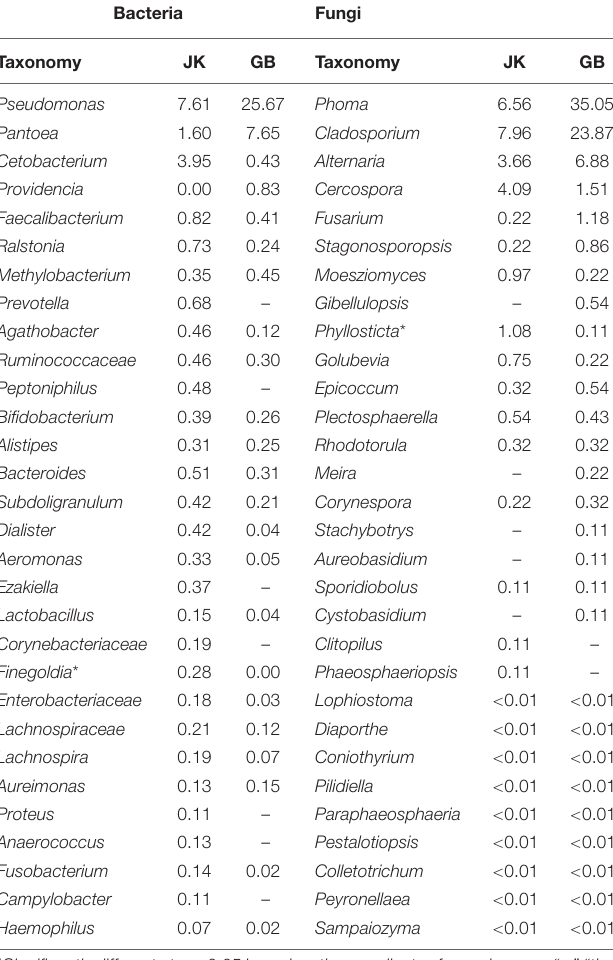
TABLE 2 | The top 30 dominant taxa and their relative abundance (%) of fungal and bacterial community OTUs based on metagenetic analysis. Bacteria